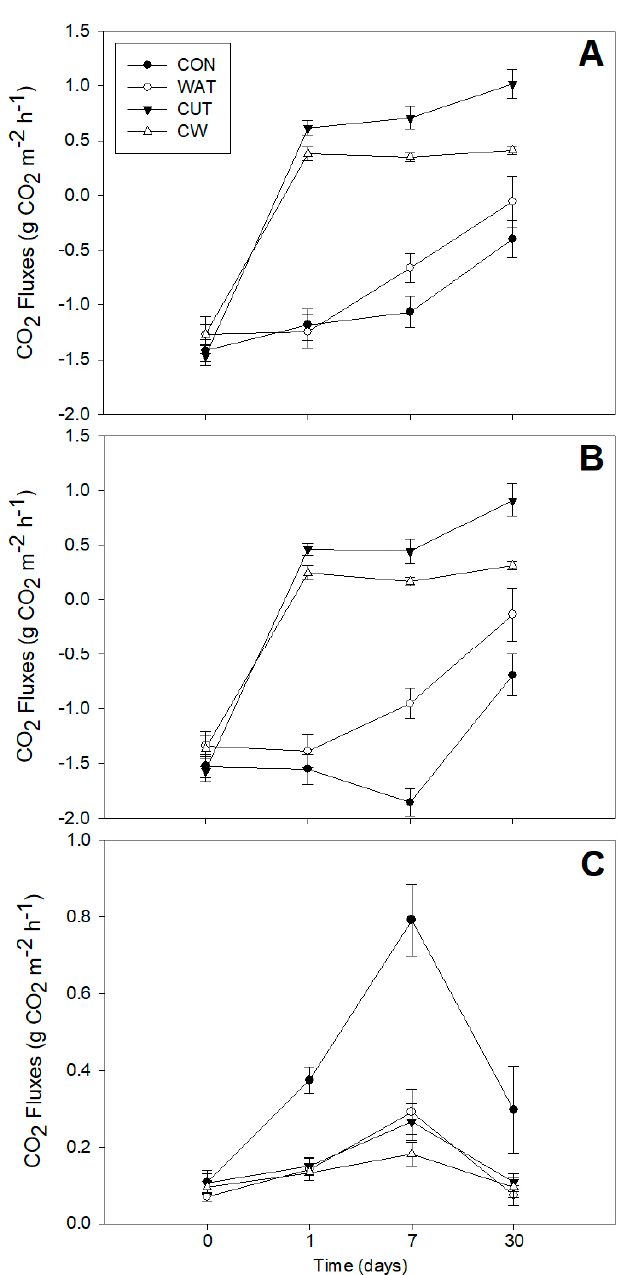
Figure 1. Whole mesocosm ( A ), plant-associated ( B ), and soil-associated ( C ) CO 2 fluxes at different sampling times (0, 1, 7, and 30 days), in experiments on G. tinctoria conducted at UCD’s Rosemount Environmental Research Station glasshouse, Dublin, Ireland, July–August 2017 (n = 12; mean ± SE). Legend: CON = control plants subjected to normal watering; WAT = plants subjected to flooding; CUT = plants that had the leaves cut from the petioles but were watered normally; CW = plants where leaves were removed and were also subjected to rhizome flooding. Note: Negative numbers indicate absorption/uptake of CO 2 , whereas positive numbers indicate emissions of CO 2